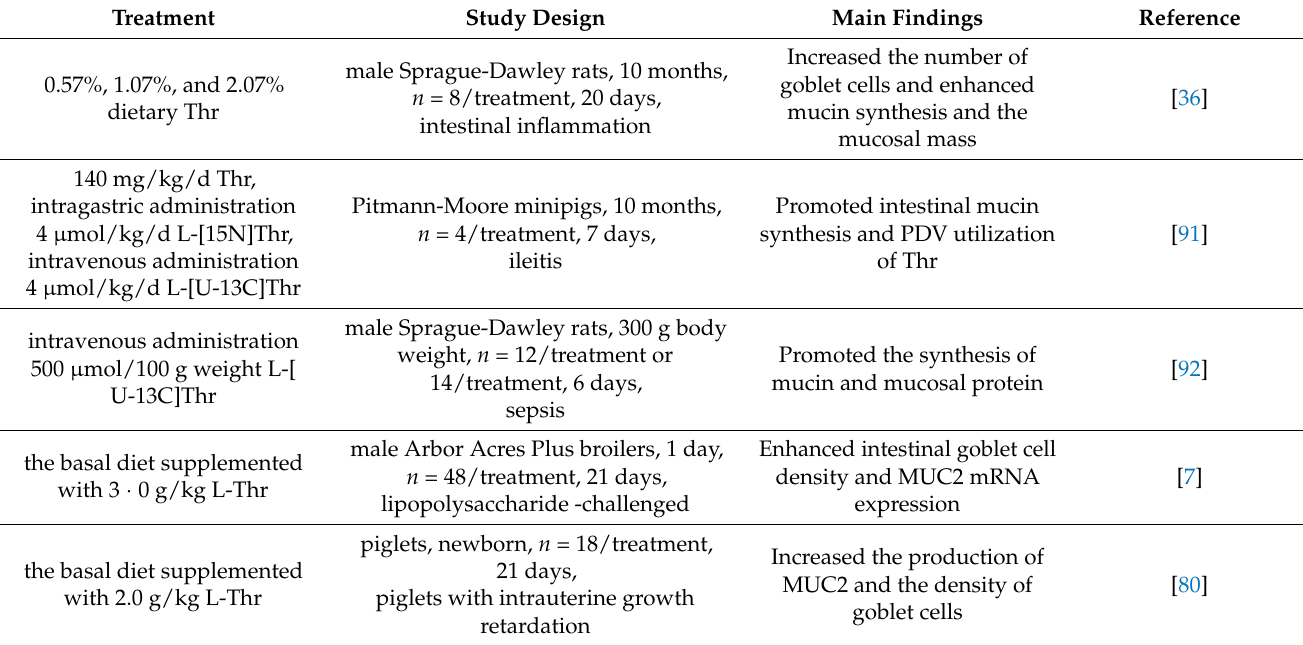
Table 1. The effects of Thr levels on intestinal barrier function in animals under pathological conditions. Treatment Study Design Main Findings